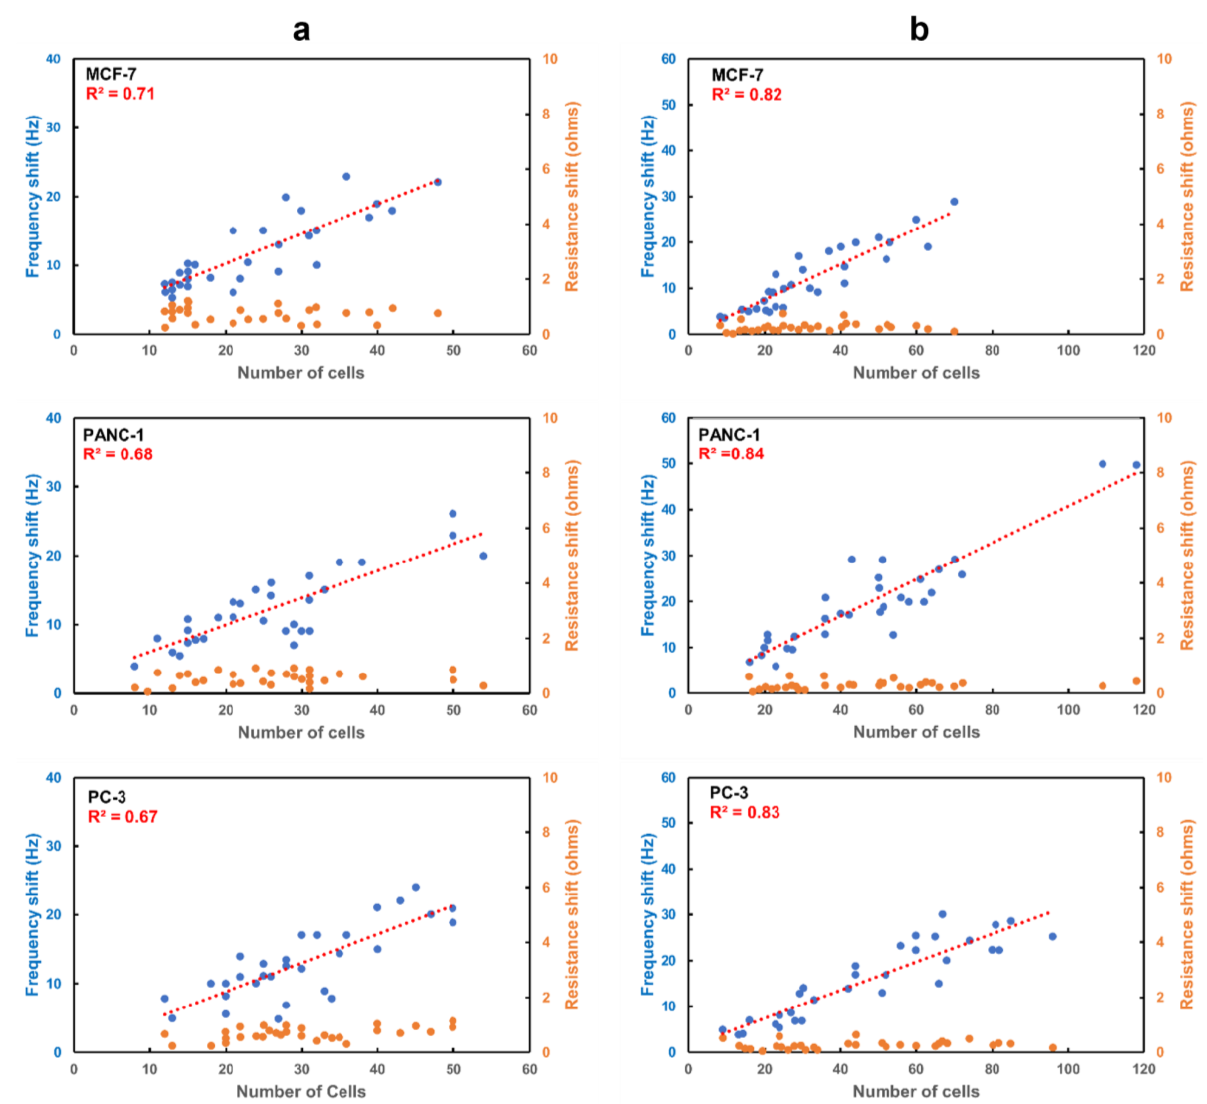
Figure 8. Frequency shift as a function of the number of attached cells on ( a ) 6 MHz keyhole electrode QCR and ( b ) 9 MHz ring electrode QCR for three different cancer cell lines, n = 30.